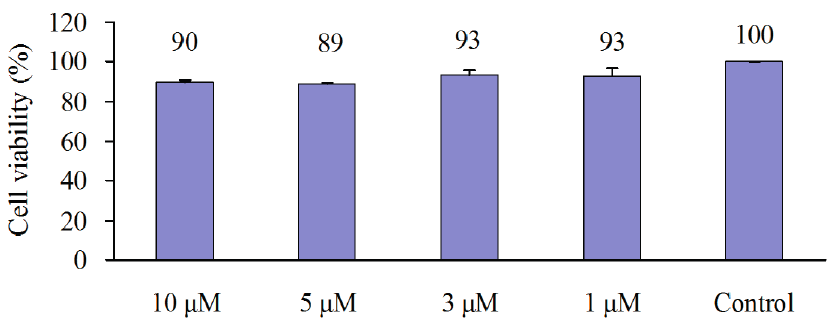
Figure 2. The 48 h proliferation assay for compound 1 in human mesenchymal stem cells (hMSC). Cell viability was measured using Cell Conuting Kit 8. Data were expressed as Mean ± SD ( n =